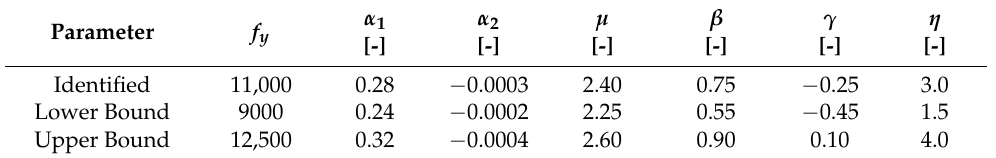
Table 6. Identified model parameters and search space for the elastomeric bearing (Bouc–Wen) element.